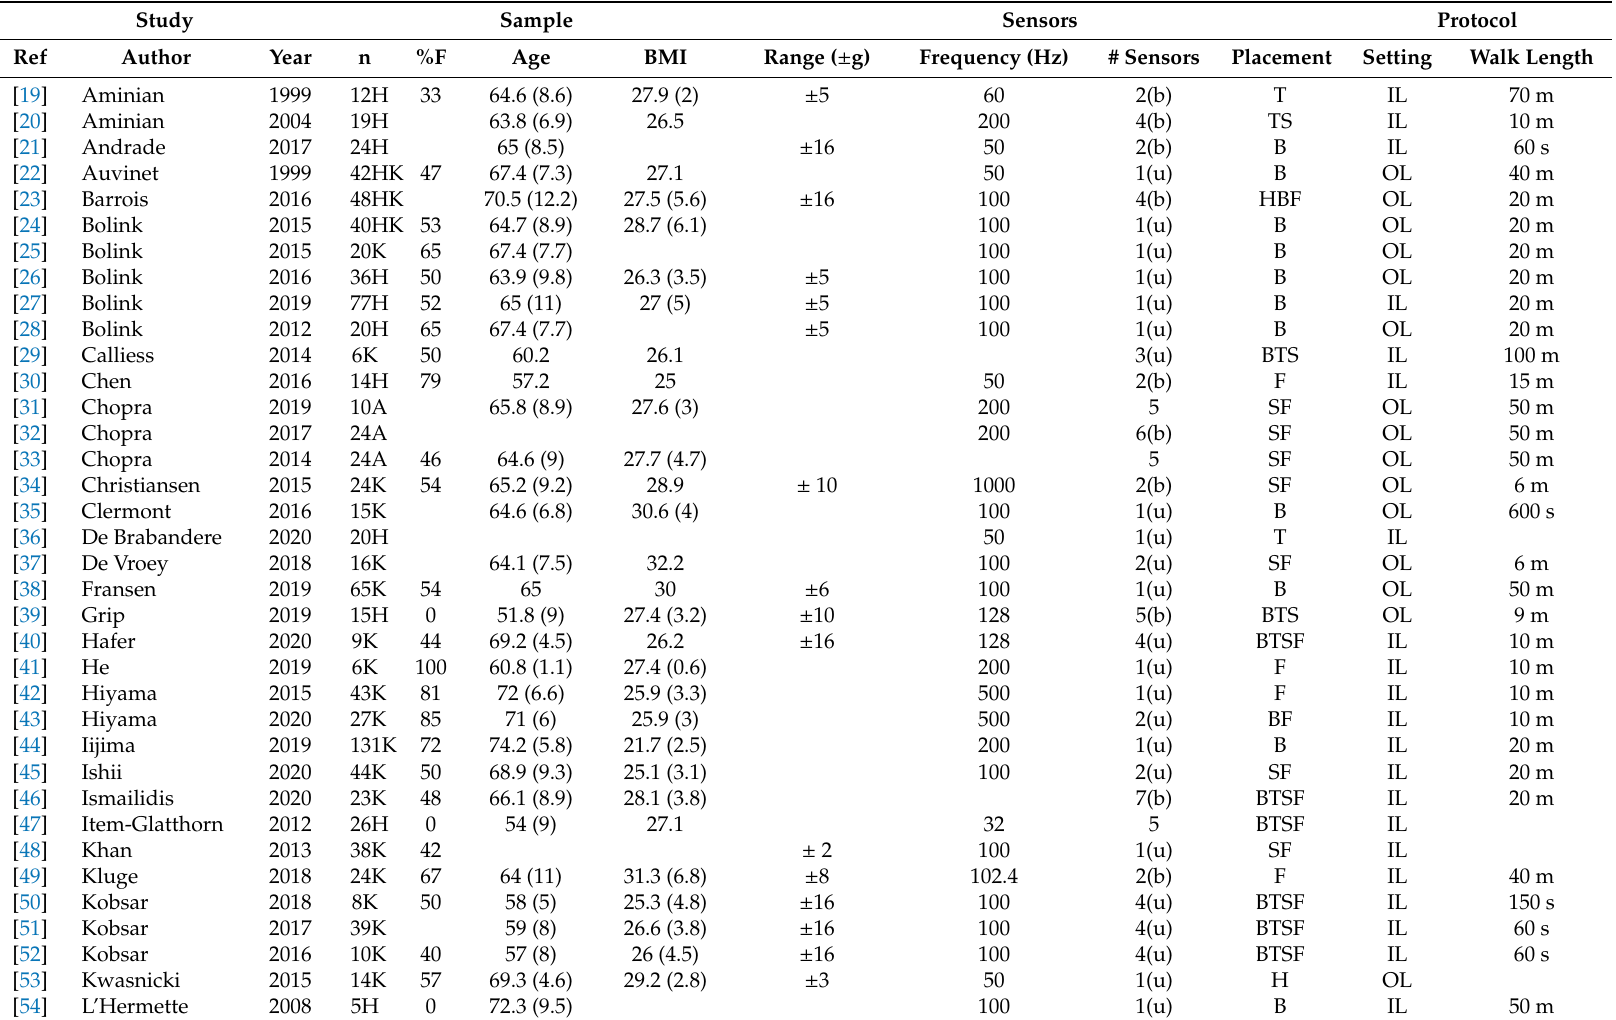
Table 2. Summary of the samples and protocols for all 72 included studies. Additional information can be found in Supplementary Tables S1 and S2. Study Sample Sensors Protocol